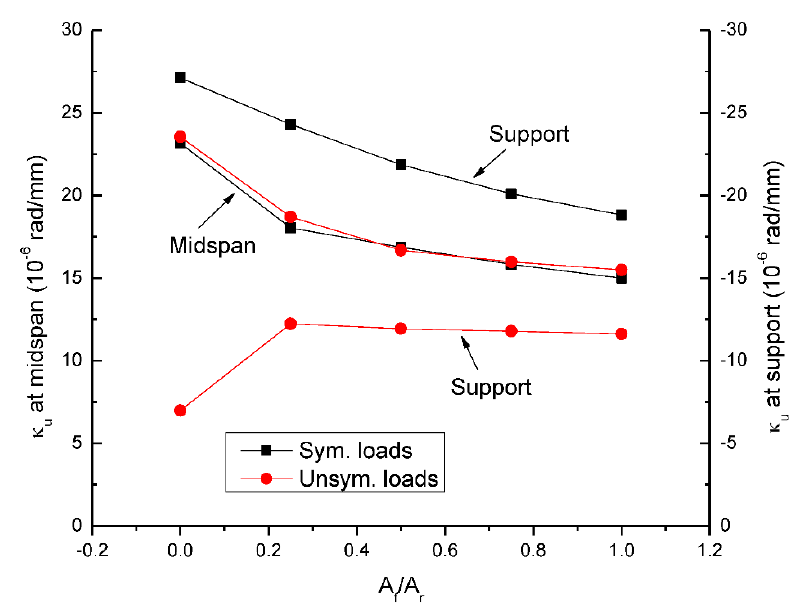
Figure 6. Change in ultimate curvature ( κ u ) with the hybrid level.